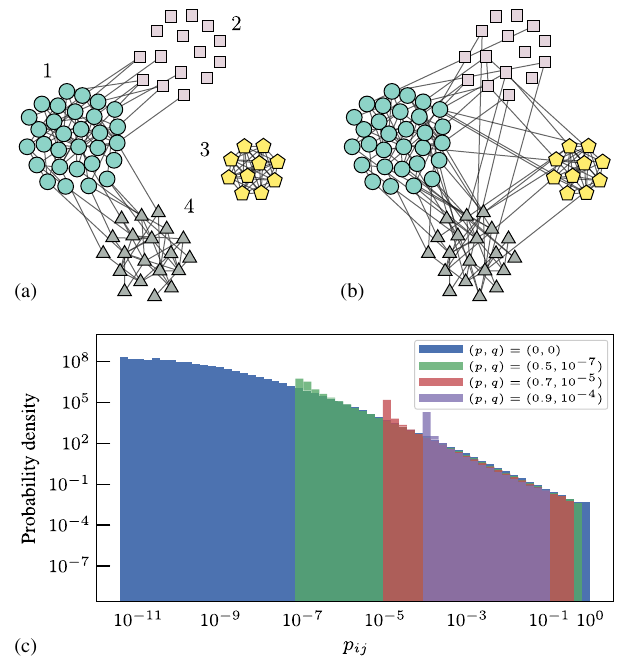
FIG. 1. (a) Illustration of a hypothetical measured network, with a priori unknown errors, but from which error estimates can be made: The lack of edges between groups 2 and 3, 3 and 4, 2 and 4, and 1 and 3 implies that the probability q of missing edges is likely to be low. Similarly, the large internal density of group 3 (which forms a clique of ten nodes) implies that the missing edge probability p must be low as well. (b) How the network in (a) would look for higher values of p and q . (c) The distribution of marginal edge probabilities p ij between every node pair, for a fit of the HDCSBM on the openflights data (see Appendix E), measured with different values of the noise parameters ð p; q Þ . As the noise magnitudes increase, the probabilities become less heterogeneous and concentrate in narrower intervals. Hence, the inference of broad connection probabilities from the data rules out the existence of strong noise in the